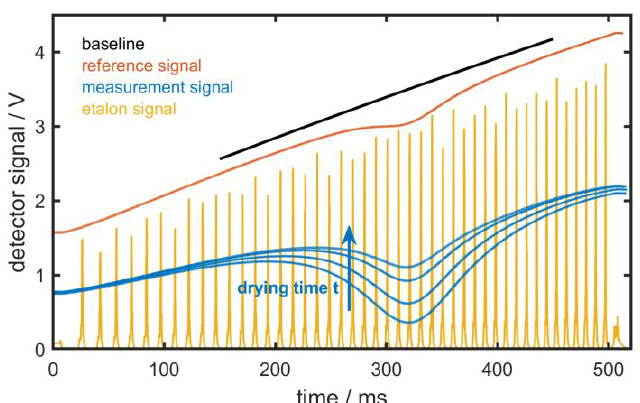
Figure 2. Typical raw single scan detector signals of the measurement path through the multipass cell (blue) at different times of the drying process (drying times: 250 s, 500 s, 750 s and 1000 s), the reference path through the Perspex chamber (red) and the etalon signal (yellow) as a function of time. The signals of the multipass-cell and the signal of the Perspex chamber clearly show the sloping background baseline (visualized as black line), caused by the triangular laser current modulation and the water absorption line at 1370 nm.